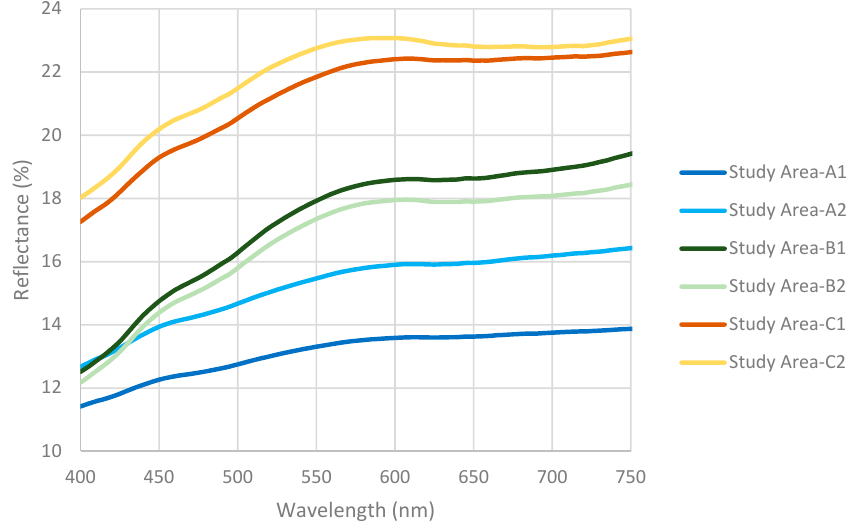
Figure 8. Spectral data of spectroradiometer for areas A1–C2.